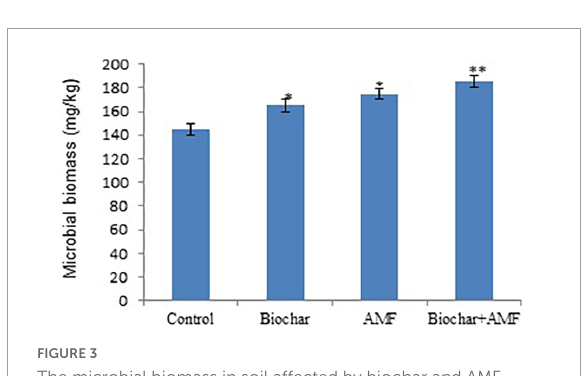
FIGURE3 The microbial biomass in soil affected by biochar and AMF under drought conditions. * P = 0.01 and ** P = 0.05.